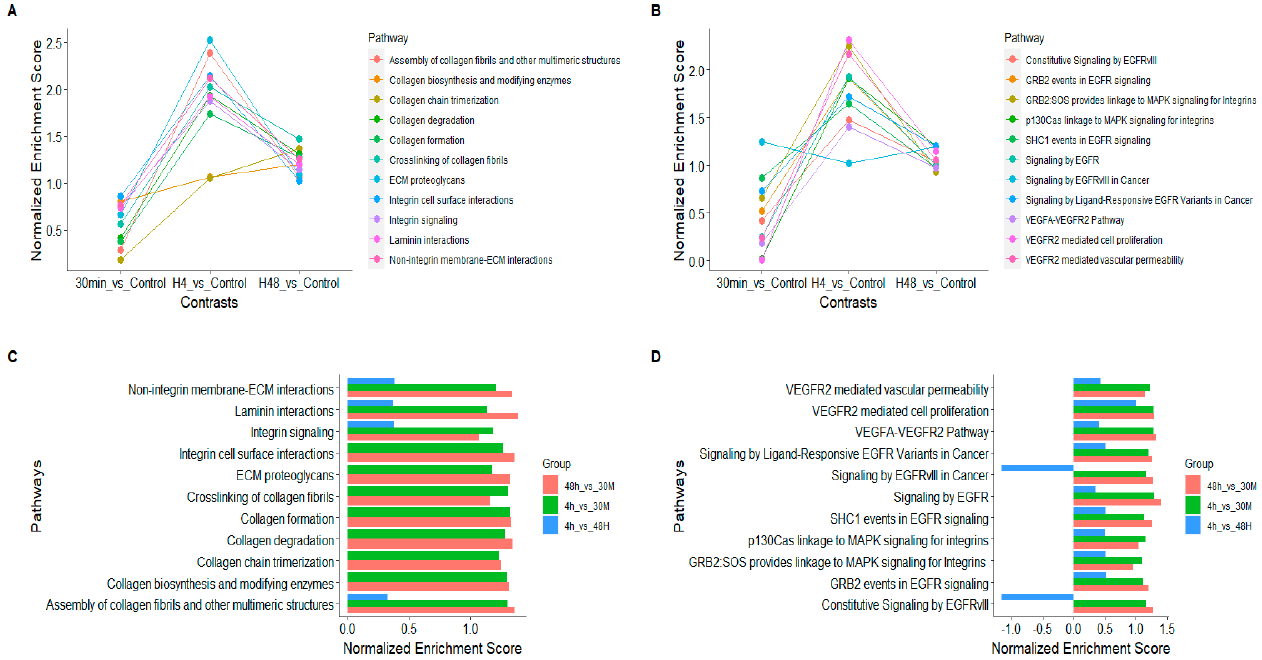
Figure 3. Receptive endometrial analogue RL95-2 cells were treated with trophoblast analogue Jar cell-derived EVs for 30 min, 4 h and 48 h to investigate the effect of trophoblastic EVs on endometrial transcriptome. Resulting transcriptomes were subjected to gene set enrichment analysis to identify enriched Reactome pathways. ( A , C ) The relative enrichment of pathways belonging to the general theme of extracellular matrix reorganization at each time point. ( B , D ) The relative enrichment of pathways belonging to the general theme of EGFR-based signalling at each time